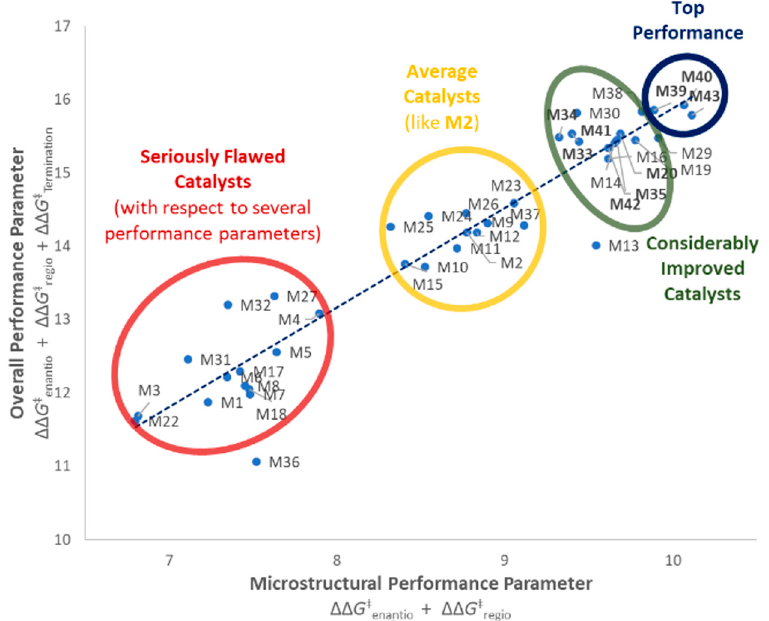
Table 8. Predicted/observed (in bold) performance properties for catalysts M39–M43 . QSAR/Exp.